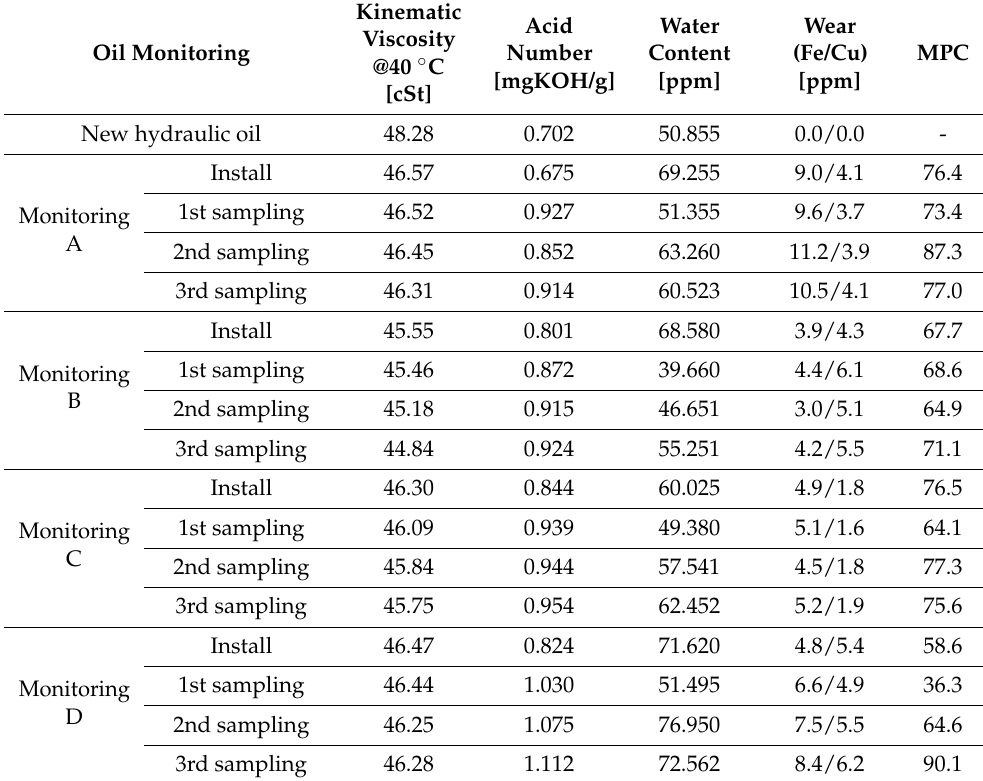
Figure 12. Kinematic viscosity monitoring results of four excavators over a 12 month period. Table 7. Results of hydraulic oil analysis based on periodic oil sampling from